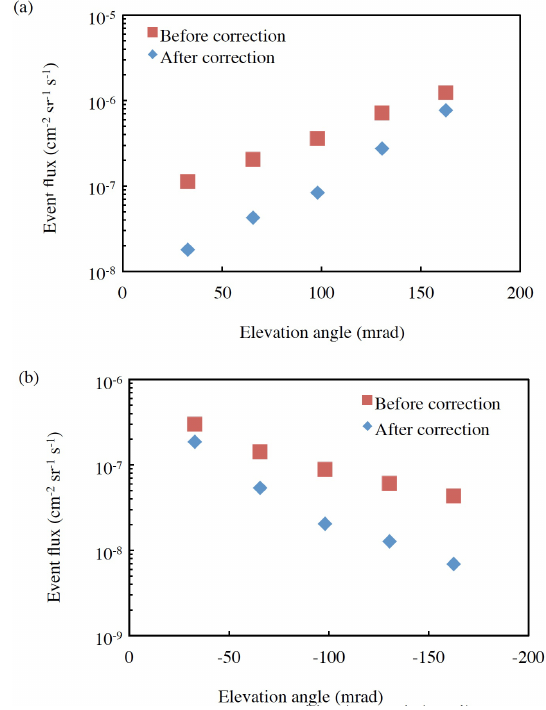
Figure 13. Elevation angle dependence on background event flux. The background levels are expected to be measured for different elevation angles with the telescope and are plotted for the events arriving from the direction of the target mountain (a) and from the side opposite to the mountain (b) . The plot also shows the back- ground event flux before (red squares) and after (blue diamonds) selecting linear trajectories from these events with a selection crite- rion of N =